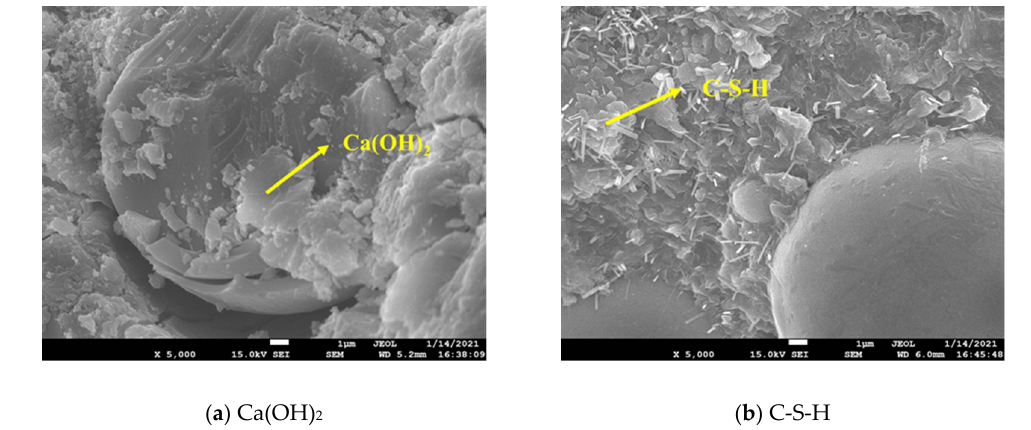
Figure 11. The hydration products Ca(OH) 2 and C-S-H: ( a ) Ca(OH) 2 ; ( b ) C-S-H.